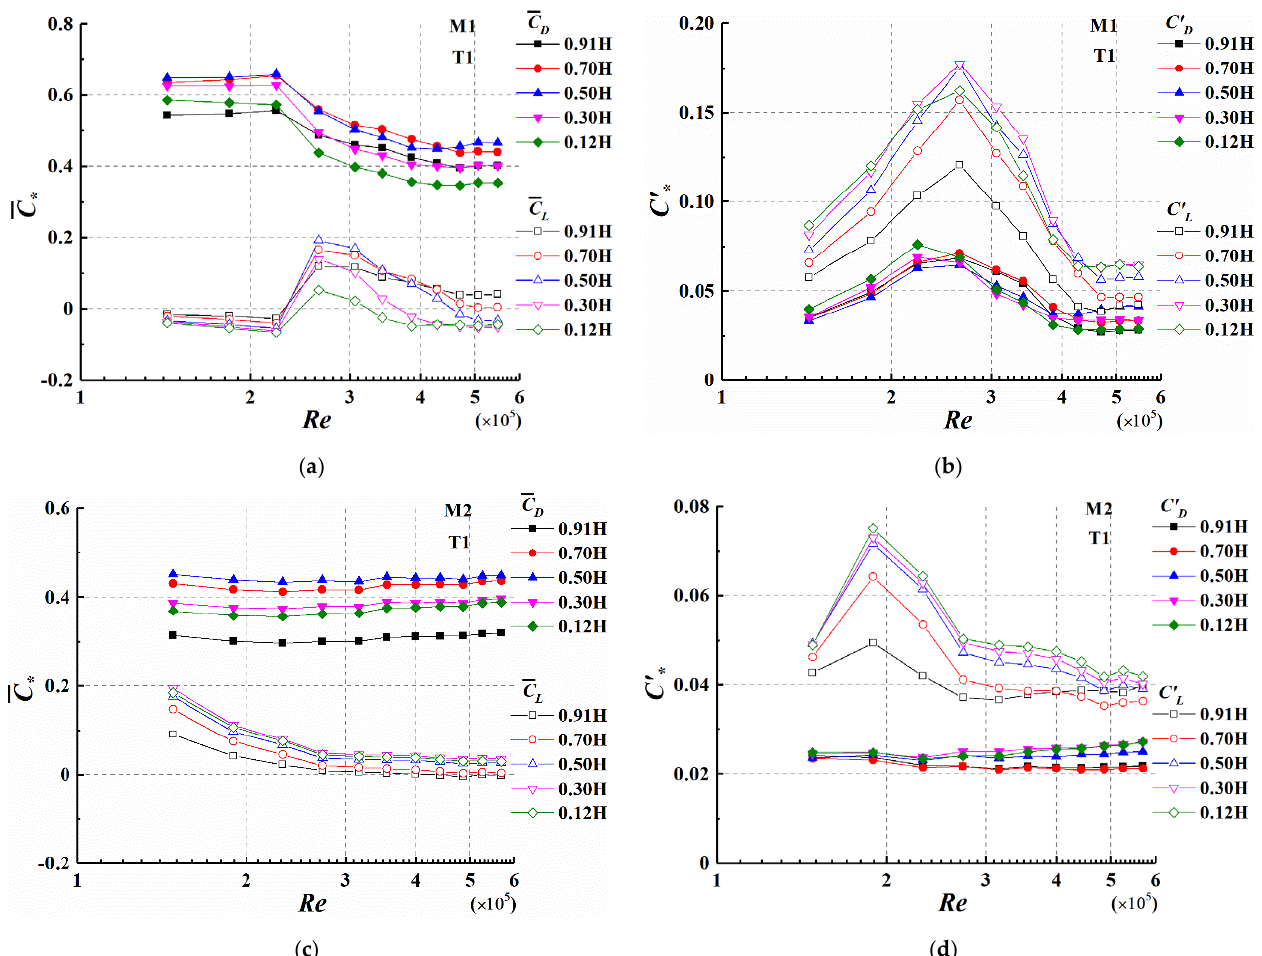
Figure 12. The variation of the local force coefficient with Re at different height of models. ( a ) M1, the mean local force coefficient; ( b ) M1, the fluctuating local force coefficient; ( c ) M2, the mean local force coefficient; ( d ) M2, the fluctuating local force coefficient.